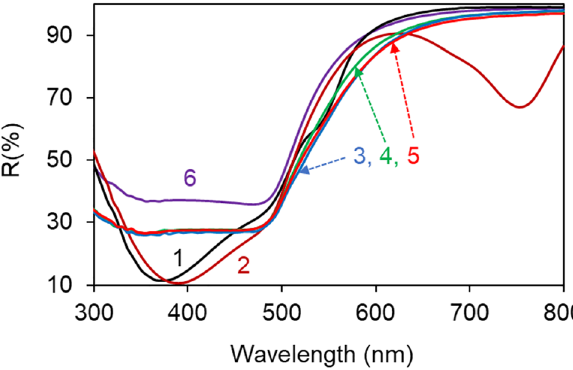
Figure 8: Reflection spectra of Rh590:PMMA (1), HITC:PMMA (2), and undoped polymers PMMA (3), PVP (4), and PS (5) on top of Au, reflection spectrum of Au (6).